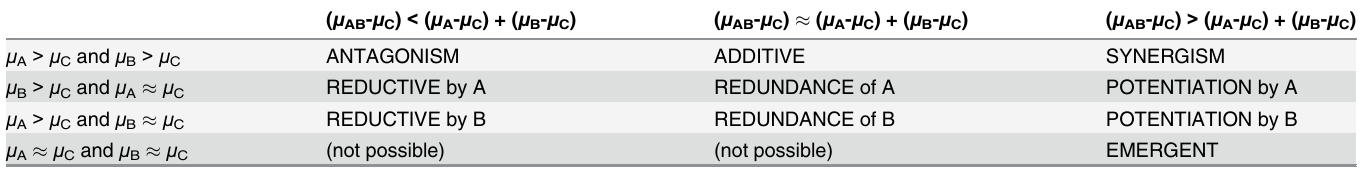
Table 2. Taxonomy of ten possible forms of interplay between a combined manipulation AB and its single constituents A and